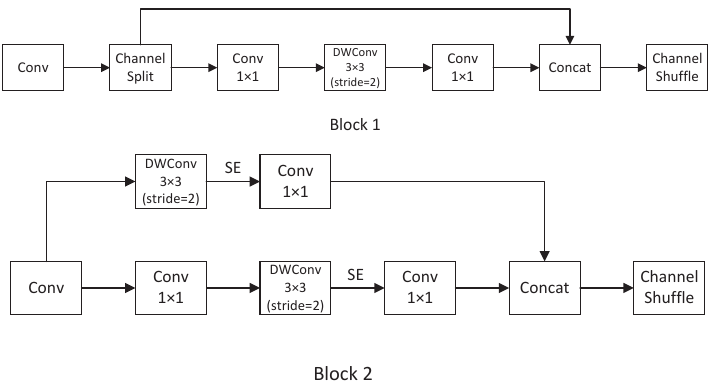
Figure 2. Shufflenetv2 module: we use different numbers of block 1 and block 2 in our network, and add SE layer in block